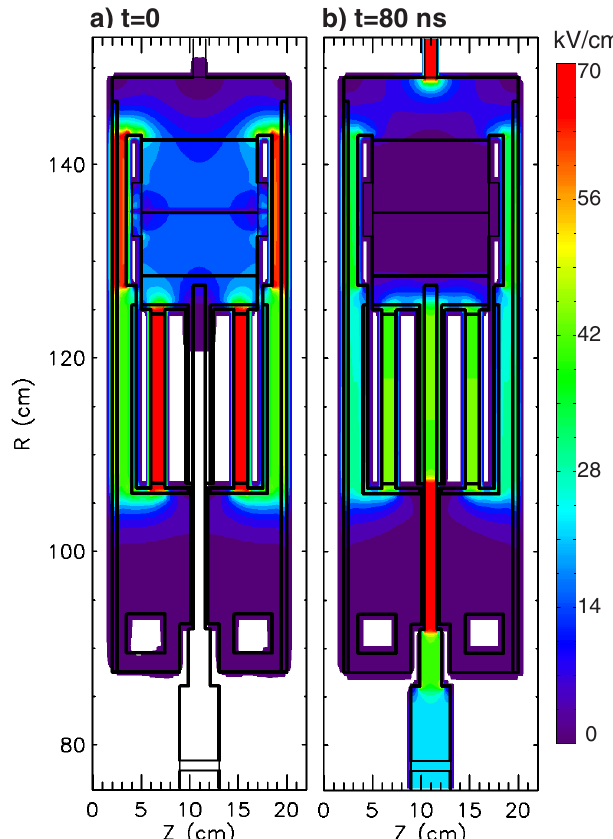
FIG. 5. (Color) Electric field magnitudes from the single-cavity 3D LSP simulation model at (a) t ¼ 0 and (b) t ¼ 80 ns . The plots show the azimuthal plane passing through the center of the switch and capacitors.